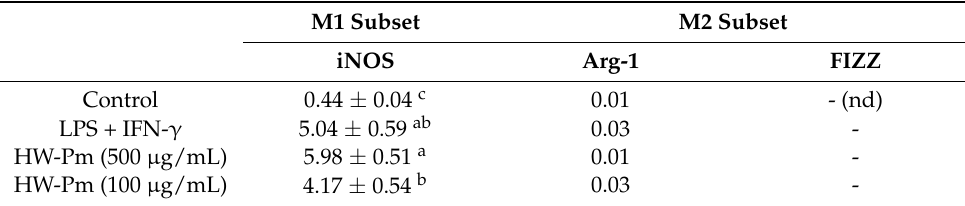
Table 1. Effect of HW-Pm on iNOS, Arg-1 and FIZZ mRNA expression in RAW 264.7 macrophages.